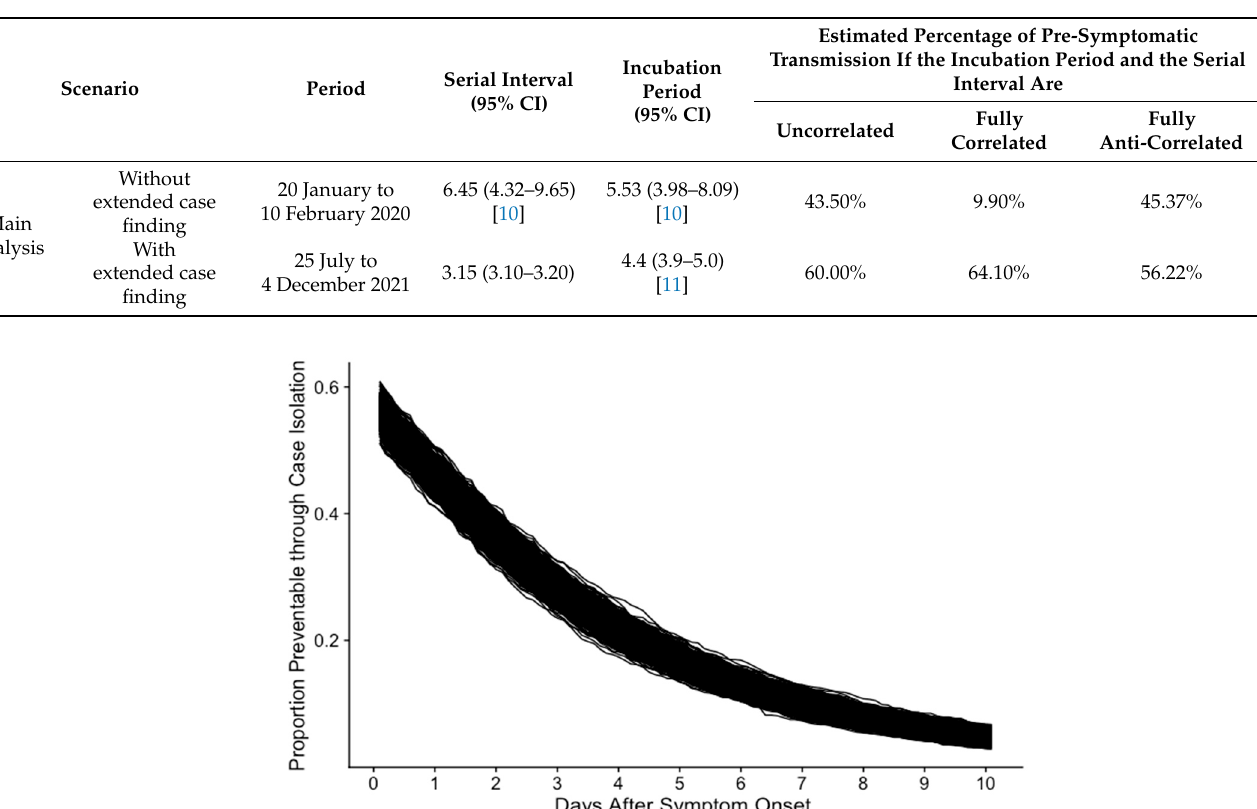
Table 1. Overview of the scenarios tested and the corresponding estimates for the percentage of transmission that may be attributable to pre-symptomatic infections.